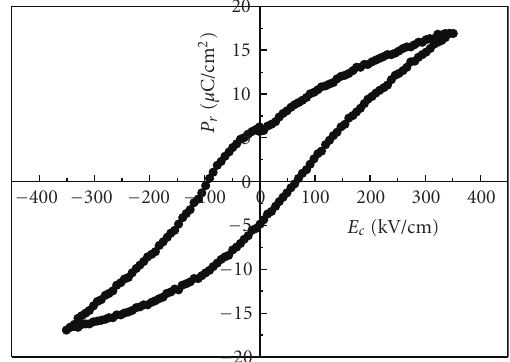
Figure 3: SEM micrograph of SBTi film annealed deposited by the soft chemical method at 700 ◦ C for 2 hours.